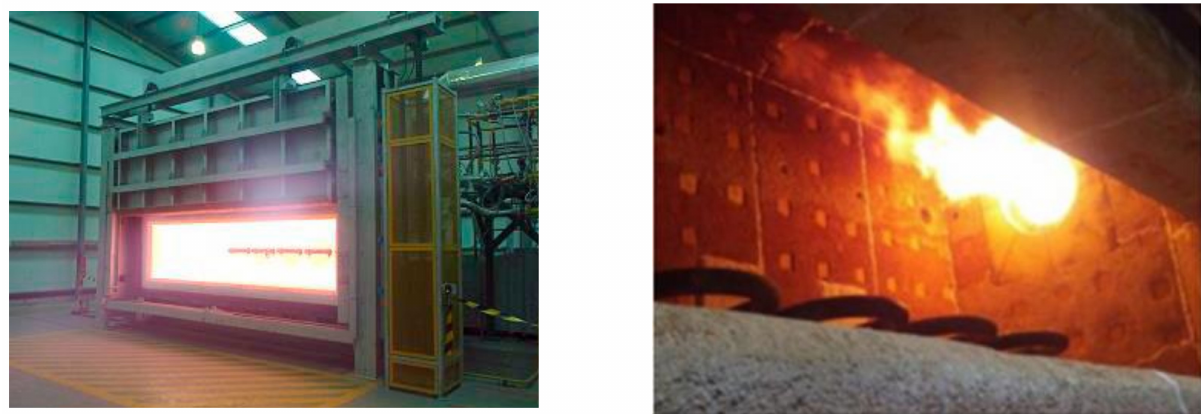
Figure 1. ArcelorMittal experimental industrial furnaces located in the Asturias (Spain) plant [22].